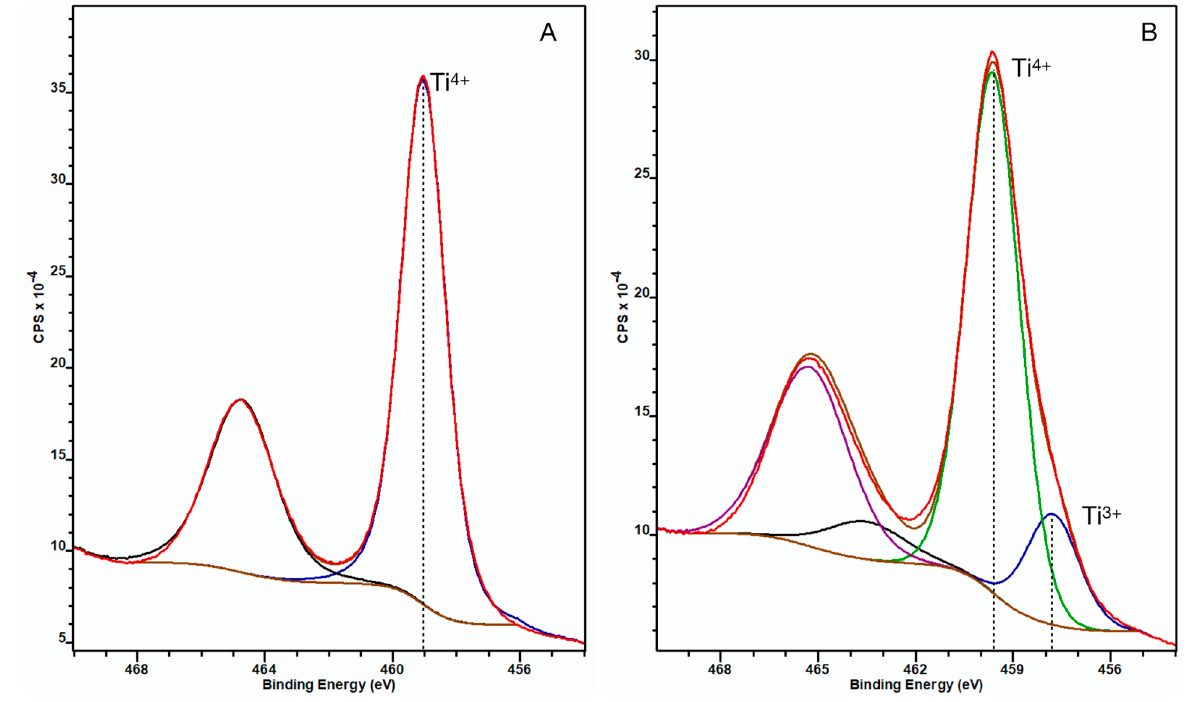
Figure 3. XPS spectra of untreated control (A) and ccH 3 PO 4 -treated NP surfaces (B) after sputter- ing. The Ti 2 p 3/2 peak appeared at 459.1 eV (blue curve) for the untreated NP surface, indicating fully coordinated Ti 4+ ions, suggesting the oxide layer was solely constituted of TiO 2 . (The black curve is the corresponding Ti 2p 1/2 component of the doublet peak.) On panel B, an additional doublet peak appeared at 458.8 eV binding energy, which indicates the presence of Ti 3+ beside Ti 4+ in the oxide layer. (Here the blue curve is Ti 3+ 2 p 3/2 , the green one is Ti 4+ 2 p 3/2 , while the black and purple curves are the corresponding Ti 3+ 2 p 1/ 2 and Ti 4+ 2 p 1/2 components of the doublets).